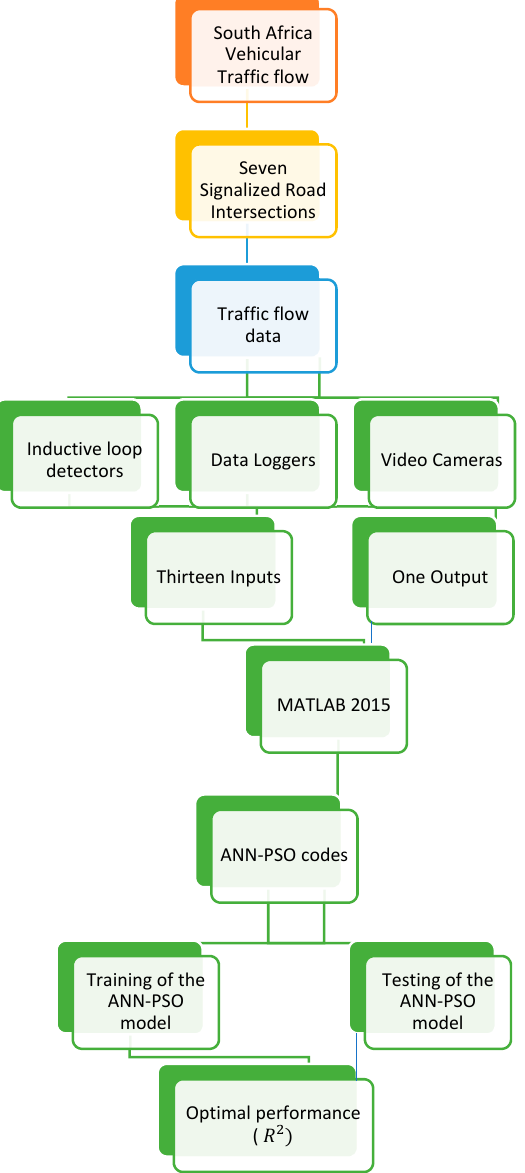
Figure 1. Research methodology.